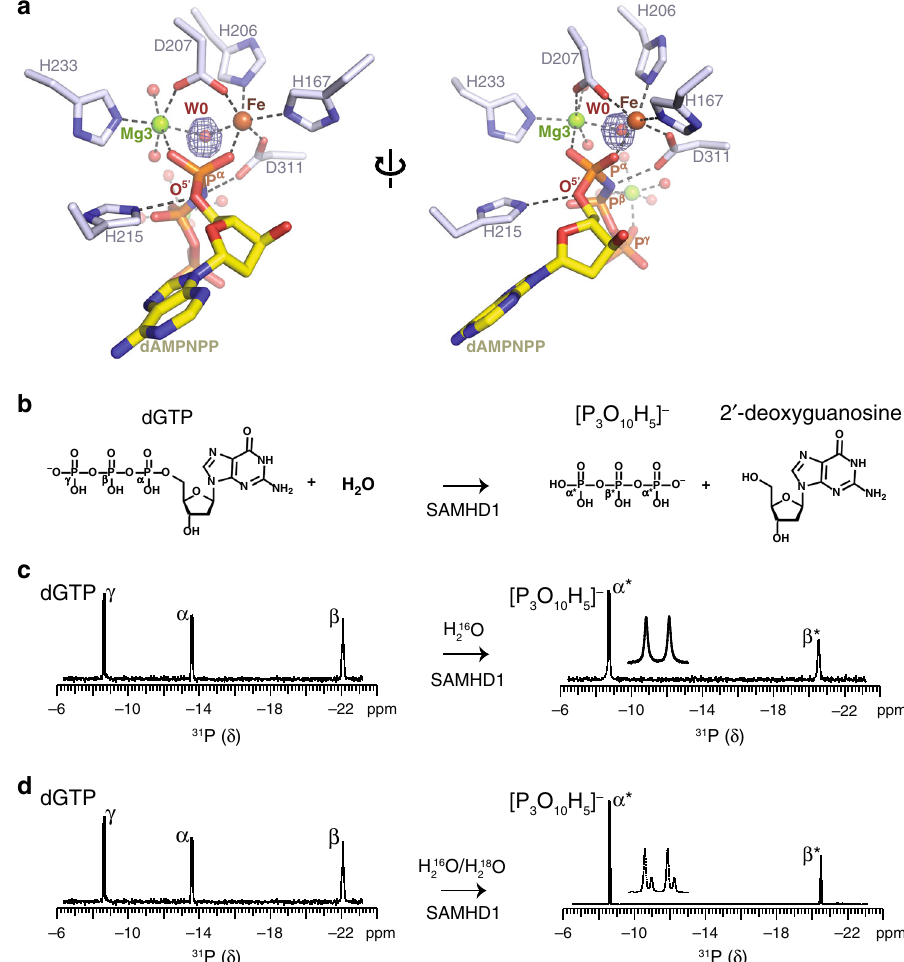
Fig. 4 NMR analysis of water-mediated SAMHD1 catalysis. a Detailed view of the bi-metallic centre in the SAMHD1-active site. Metal ions and coordinated water molecules are shown as spheres, coloured by atom type. W0 is the activated water molecule positioned between the HD-bound Fe and Mg3, and orientated for nucleophilic attack on the α -phosphate. The electron density shown in blue mesh is the F o − F c map calculated during model building prior to inclusion of W0, contoured at 6 σ . b Chemical structures of the dGTP substrate and deoxyguanosine and triphosphate products of SAMHD1 hydrolysis, the α , β and γ -phosphate of dGTP together with the α *- and β *-phosphate of triphosphate are labelled. c , d SAMHD1 hydrolysis of dGTP monitored by 31 P NMR. Spectra of dGTP substrate (left) and the triphosphate product (right) after 0 and 3 h incubation with SAMHD1 are shown. Assigned 31 P resonances of the α -, β - and γ -phosphate of dGTP and α - and β -phosphate of the triphosphate product species are labelled. Product resonances are marked with asterisks. An expanded view of the α *-phosphate doublet resonance is shown inset. In c the reaction was carried out in solvent comprising 1:1 mixture of H 2 O 16 and H 2 O 18 . The satellite peaks on α *-phosphate doublet resonance result from the O 18 isotope effect, demonstrating that the reaction proceeds via a nucleophilic attack from a water molecule on the α -phosphate that is subsequently transferred into the triphosphate